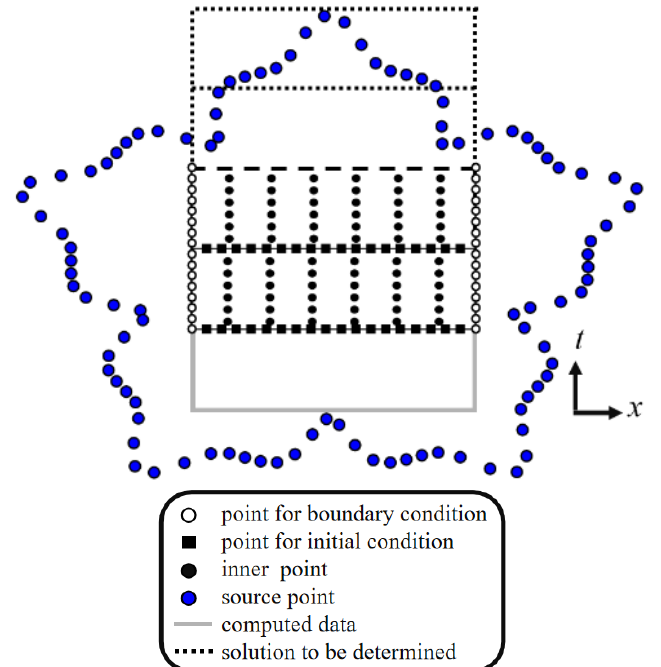
Figure 4. Illustration of the collocation scheme for one-dimensional ST marching method.